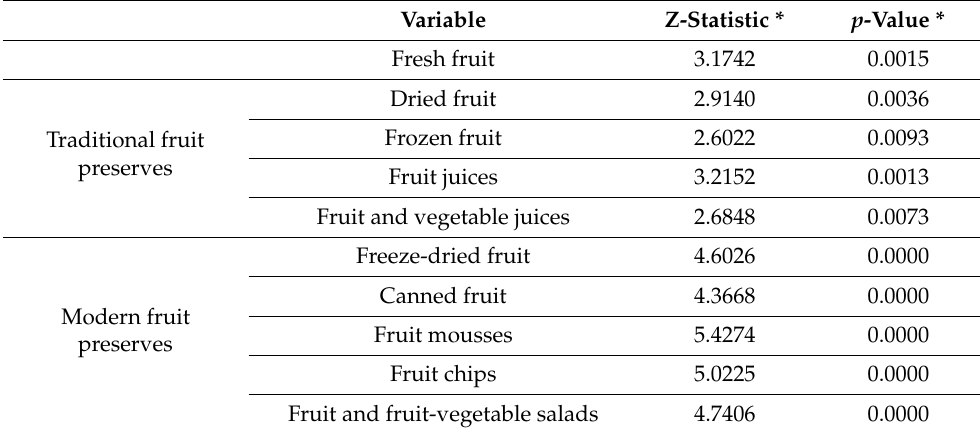
Table 3. Variation in frequency of consuming fruits and fruit preserves for innovators and non-